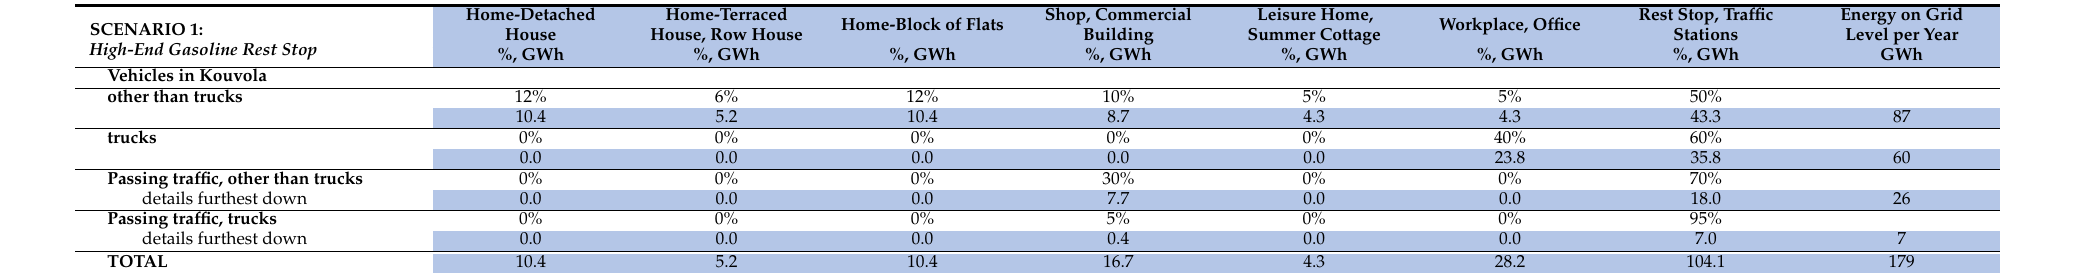
Table A2. Kouvola-based and passing traffic: subdivision of additional energy into user groups. Percentages indicate the share of consumption